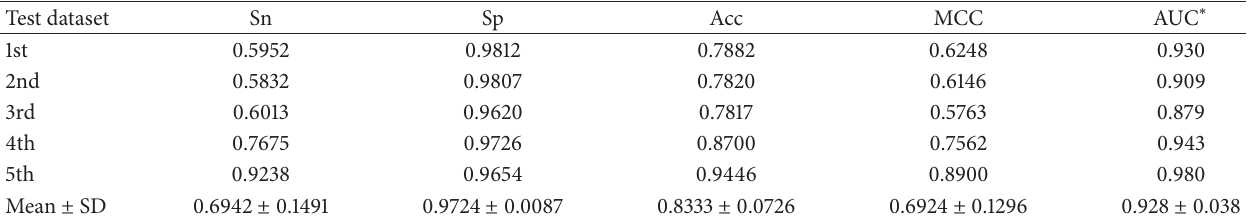
Table 5: Performance qualities measure for test dataset by using the models from the corresponding training dataset.